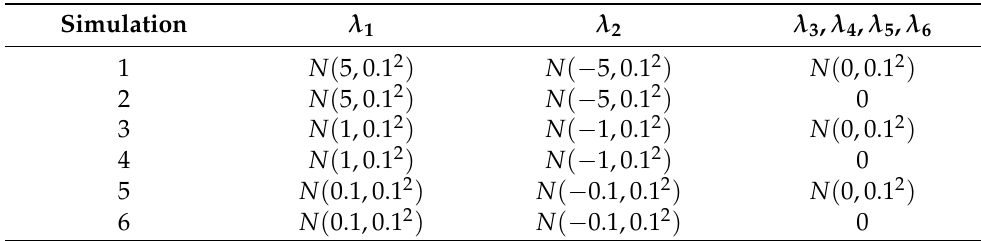
Table 3. Settings for λ j . For each simulation, the first 2 factors are contributing factors, and other 4 factors contribute little or 0 to GDP